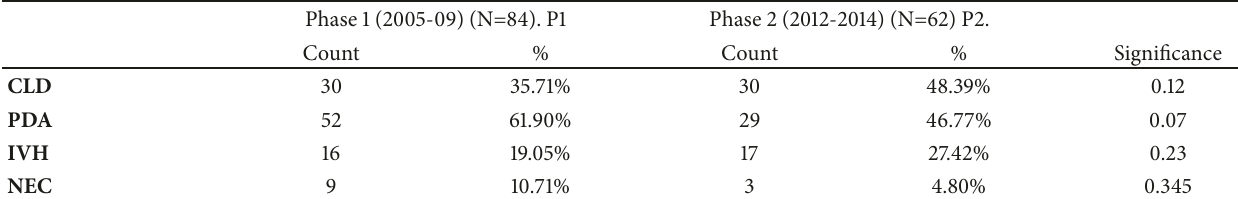
Table 5: Morbidity before hospital discharge between the two periods of